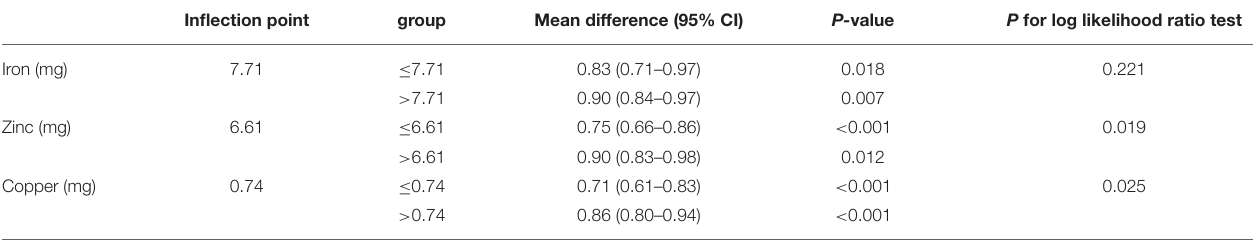
TABLE 5 | Threshold effect analysis of iron, zinc and copper on the prevalence of total CVD risk using piecewise binary logistic regression models. Inflection point group Mean difference (95% CI) P-